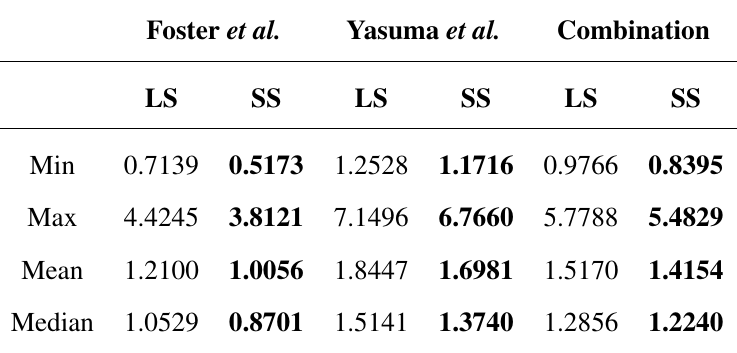
Table 6. S-CIELAB results: average result for 37 cameras using a leave-one-out paradigm (Least-Squares (LS), Spherical Sampling (SS)). Foster et al. Yasuma et al. Combination LS SS LS